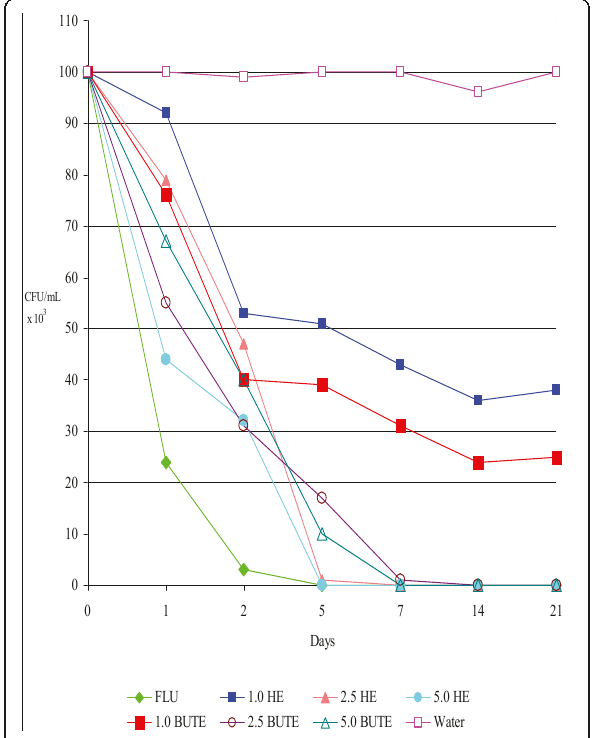
Figure 2 Colony-forming units (CFU/mL) of yeasts in the vaginal exudate of Wistar rats treated intravaginally with hydroalcoholic (HE) and butanolic (BUTE) extracts of Sapindus saponaria at 1.0%, 2.5%, and 5.0%, 100 μ g of fluconazole, or sterile distilled water at 1, 24, and 48 h after induction of the vaginal infection, followed for up to 21 days . Each curve represents the mean (± standard deviation) of the CFU of five rats, in two independent experiments. Experimental vaginal infection by C. albicans resistant to itraconazole